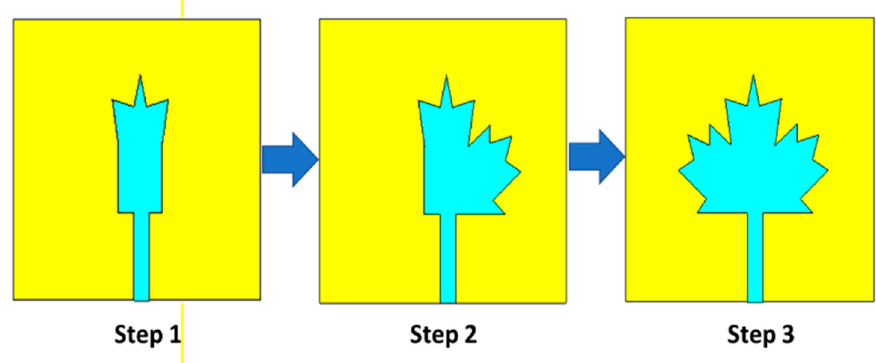
Figure 3. Varied design steps of the proposed antenna.